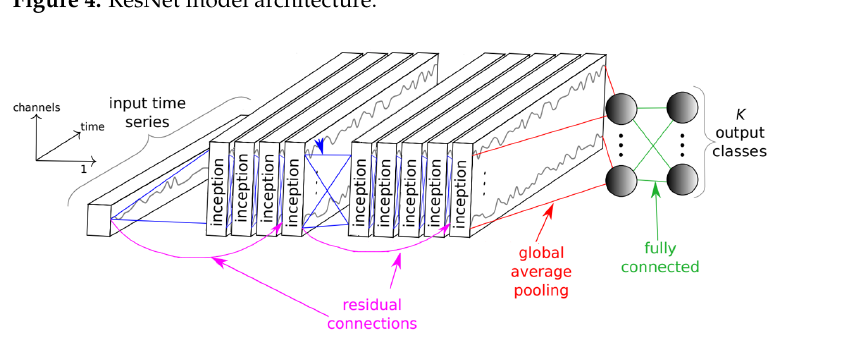
Figure 5. Inception model architecture.